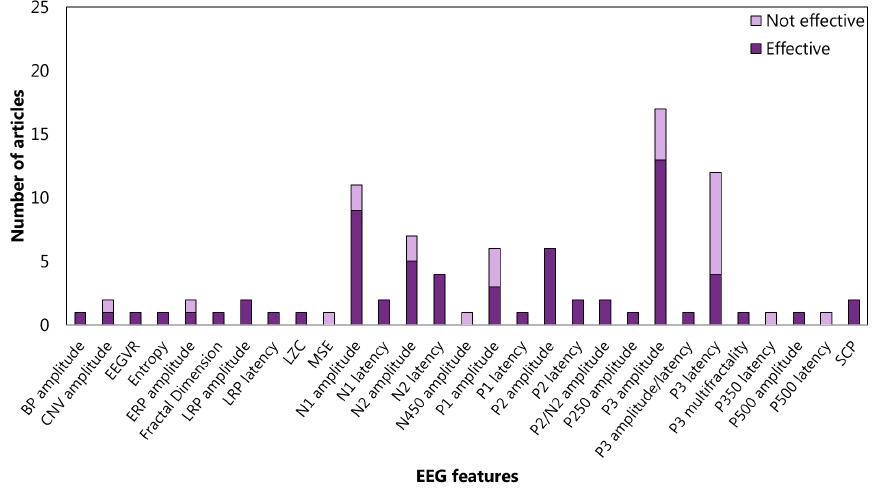
Figure 5. Articles focusing on the relationship between EFs from cluster inhibition and EEG fea- tures from time domain. P300 amplitude is the feature most studied: 12 articles verified (effective) the relationship, and 3 articles did not (not effective). LZC: Lempel–Ziv complexity; EEGVR: elec- troencephalogram valid rate. MSE: multi-scale entropy. SCP: slow cortical potentials; and ERP: event-related potential.